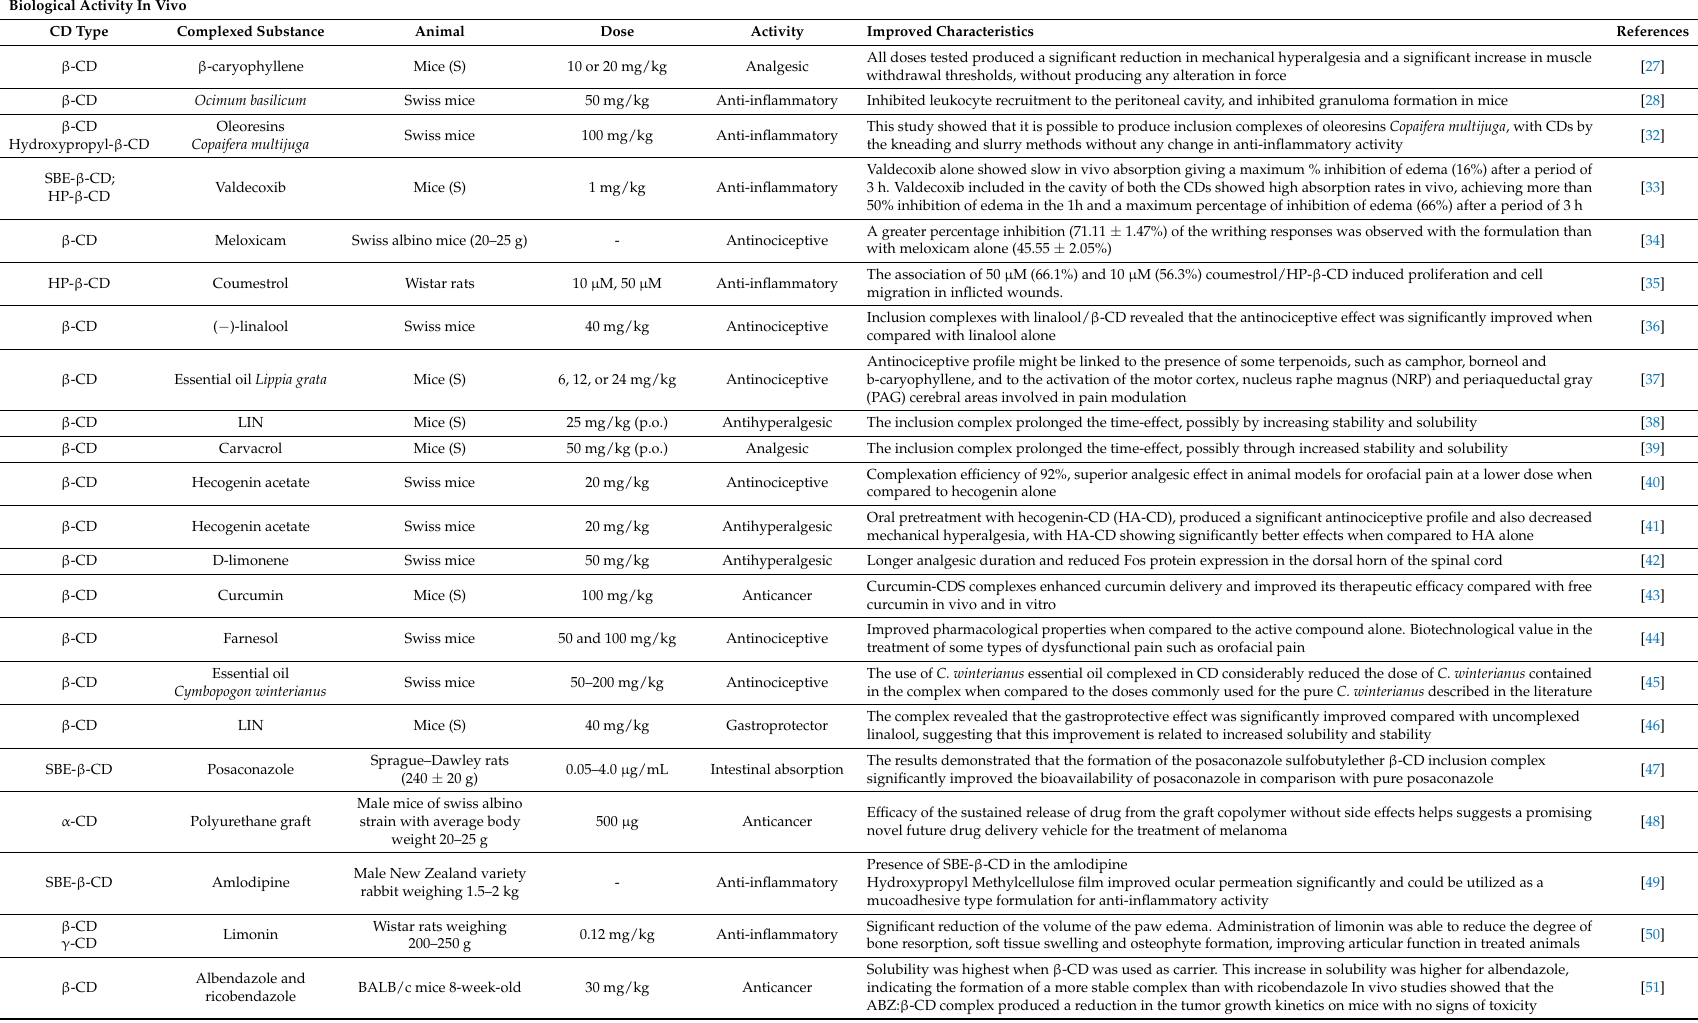
Table 1. In vivo studies of cyclodextrin inclusion